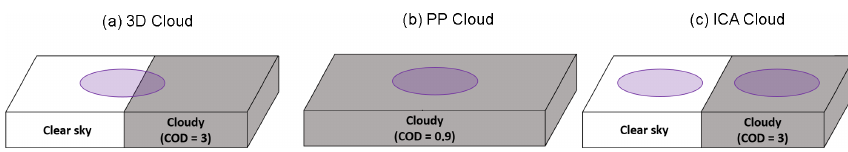
Figure 11. Conceptual representation of cloud models used for the HSR lidar simulations: (a) box-cloud model (3D), (b) plane-parallel and homogeneous (PP) model, and (c) independent column approximation (ICA) cloud. The purple circles represent the lidar footprint location for the simulations.